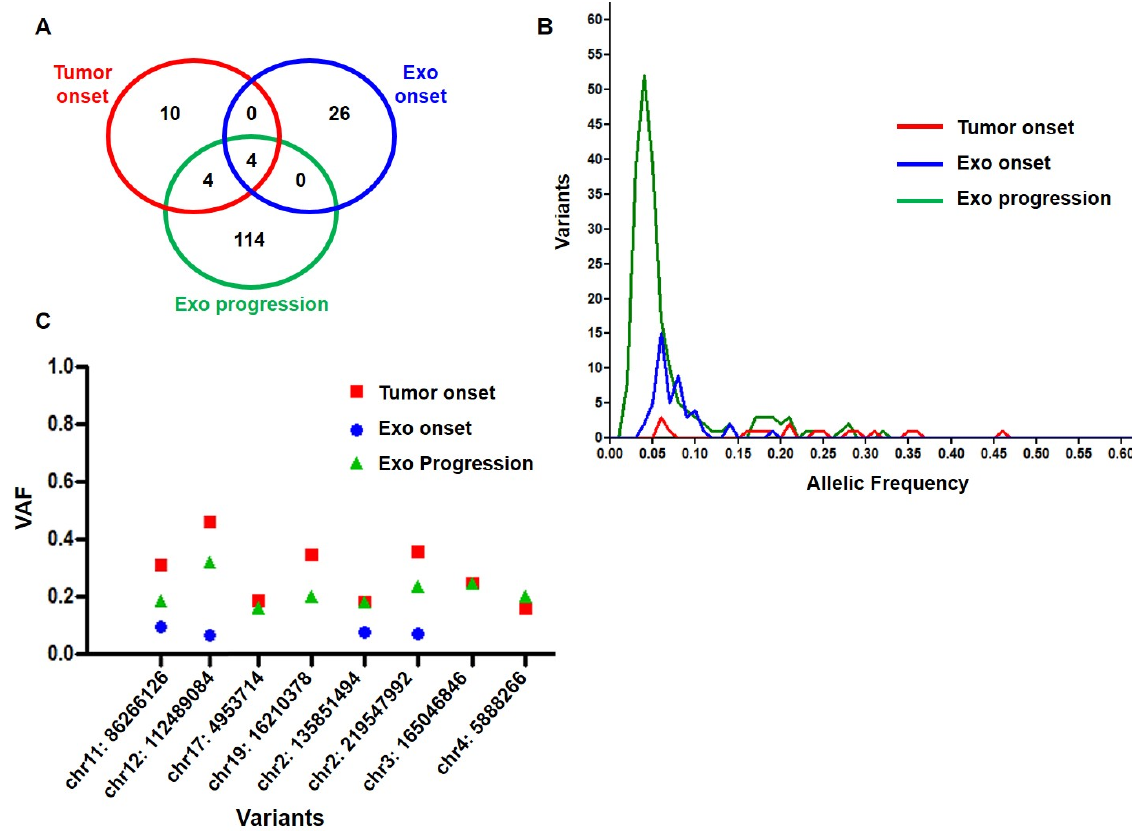
Figure 3. Somatic SNV analysis. ( A ) Venn diagram of somatic SNVs in common among exo-DNA at onset, exo-DNA at progression, and the corresponding tumor DNA at onset. ( B ) Somatic SNV frequency in exo-DNA at onset, exo-DNA at progression, and tumor DNA at onset ( C ) Frequency of the somatic SNVs in common among tumor DNA, exo-DNA at onset and exo-DNA at progression. (VAF = variant allele frequency).